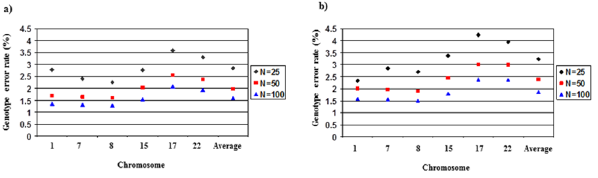
Figure 3. Genotype error rates according to Pima Indian reference population size when a) 1% or b) 20% of genotypes were masked.